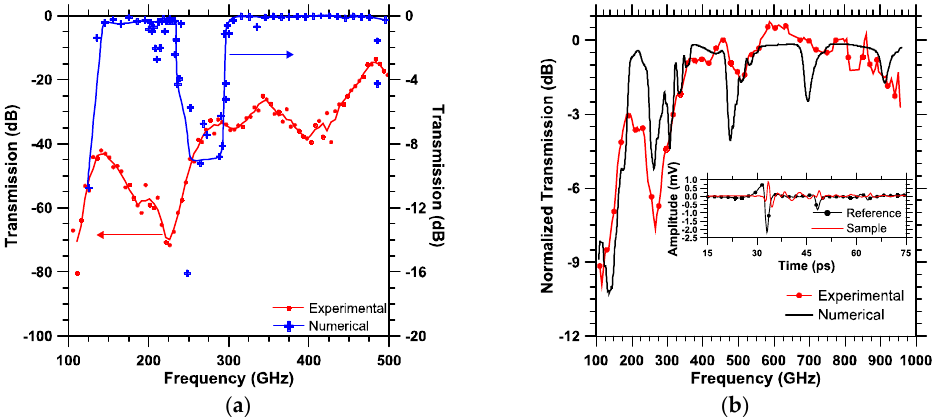
Figure 3. ( a ) Experimental and numerical transmission of ARROW A (93 mm long); ( b ) Experimental and numerical transmission of the Bragg fiber (100 mm long). Inset the reference and sample electrical